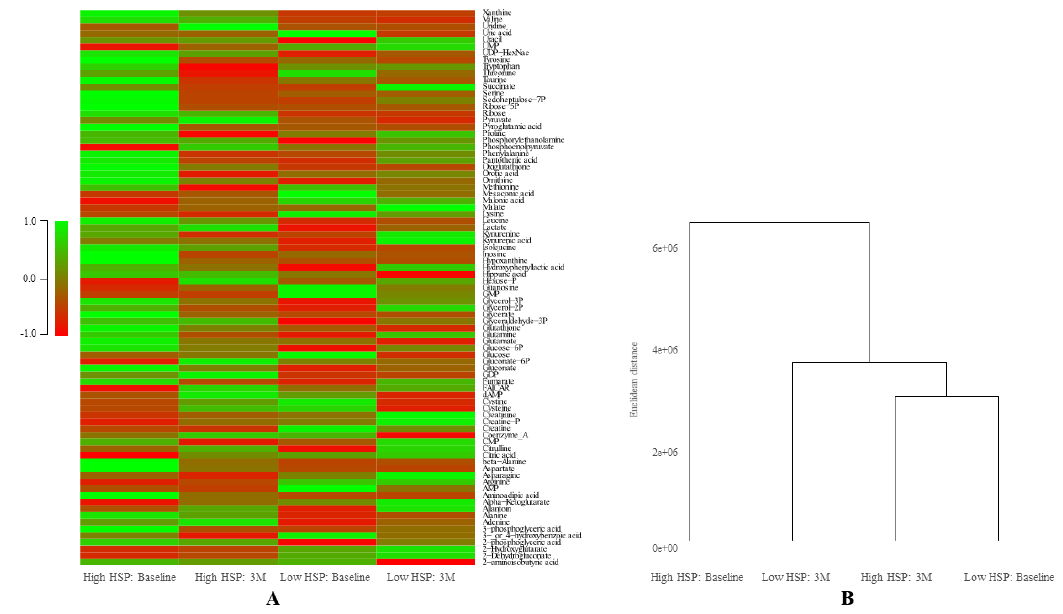
Figure 5. HSP level and L-glutamine supplementation affects metabolic phenotypes. ( A ): Heat map of the absolute levels of all 83 metabolites for high HSP: baseline, high HSP: 3-month follow-up (3M), low HSP: baseline and low HSP: 3M. The pooled group high HSP at baseline is distinct from the other groups. ( B ): Dendrogram showing the hierarchical clustering using the Euclidean distance with average linkage for all four groups.